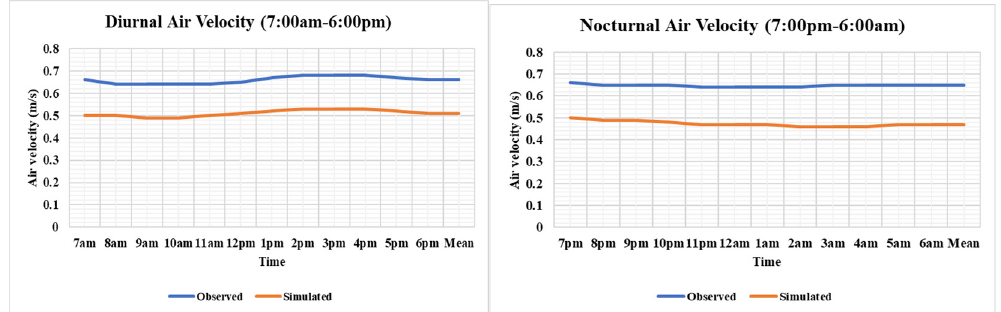
Figure 6. Measured and simulated results of diurnal and nocturnal relative humidity at SM.